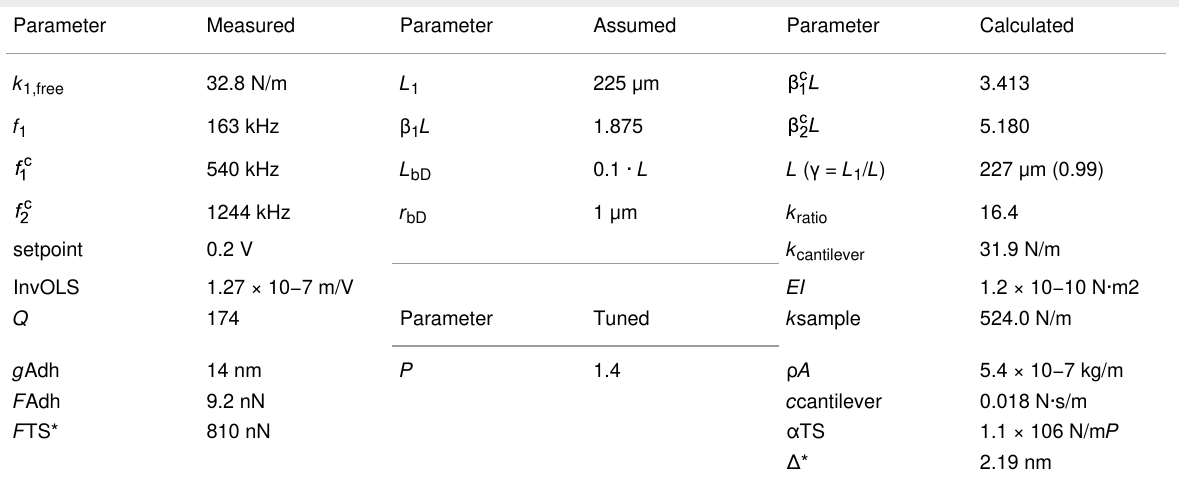
Table 1: Parameter identification from AFM measurements. Parameter Measured Parameter Assumed